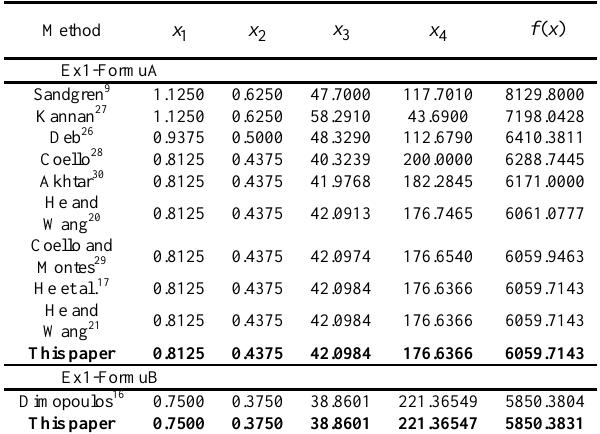
Table 4. Comparison of the best solution for the pressure vessel design problem.